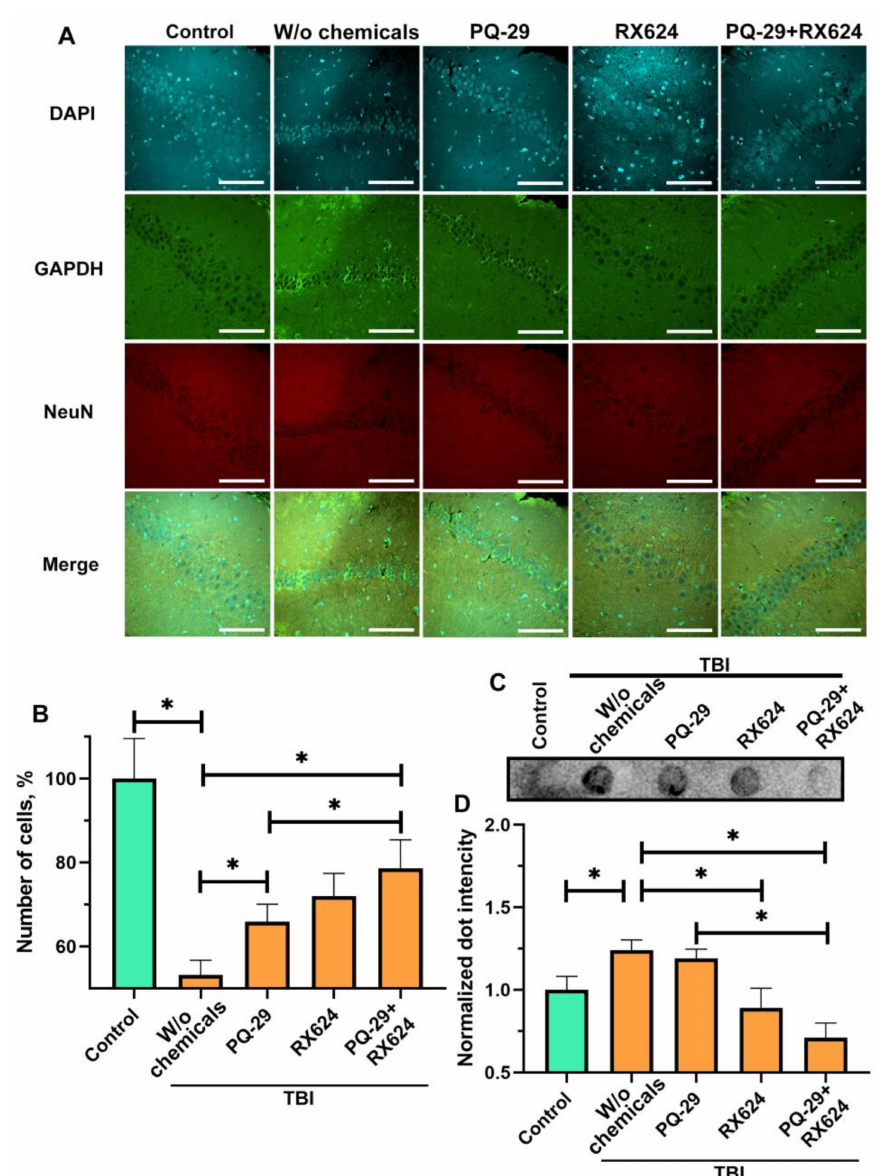
Figure 5. Analysis of the number of GAPDH-containing aggregates in the hippocampus of trauma- tized rats after a therapeutic course with the use of RX624 and PQ-29. The rats were divided into 5 groups: the control group (control), consisting of naïve animals, and 4 TBI groups, consisting of traumatized animals that received intraperitoneal injections of drugs in accordance with the captions in the figure. ( A ) The confocal microscopy data are presented. Rats’ brains from different groups were sliced and stained with DAPI (cyan) and antibodies against GAPDH (green) and NeuN (red). The CA1 hippocampus field is shown. Scale bar 10 µ m. ( B ) The number of cell nuclei stained with DAPI was normalized to that in the hippocampus of control animals and presented as histogram bars. For each group, no fewer than 500 cells were counted. ( C ) Result of GAPDH aggregate quantity analysis in the rat hippocampus by filter trapping, followed by hybridization with specific anti-GAPDH antibodies. Representative image shown. ( D ) The result of the quantification of dot intensity obtained from the analysis of the amount of GAPDH. The results were normalized to the mean GAPDH staining intensity in the hippocampi of naive rats. The mean values ± standard deviations of the results of the analysis of at least three rats from each group are shown; differences are significant at * p < 0.05 (Mann–Whitney